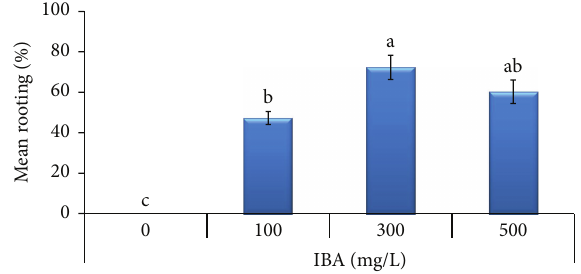
Figure 8: The Effect of dipping in different concentrations of IBA on percentage of rooted